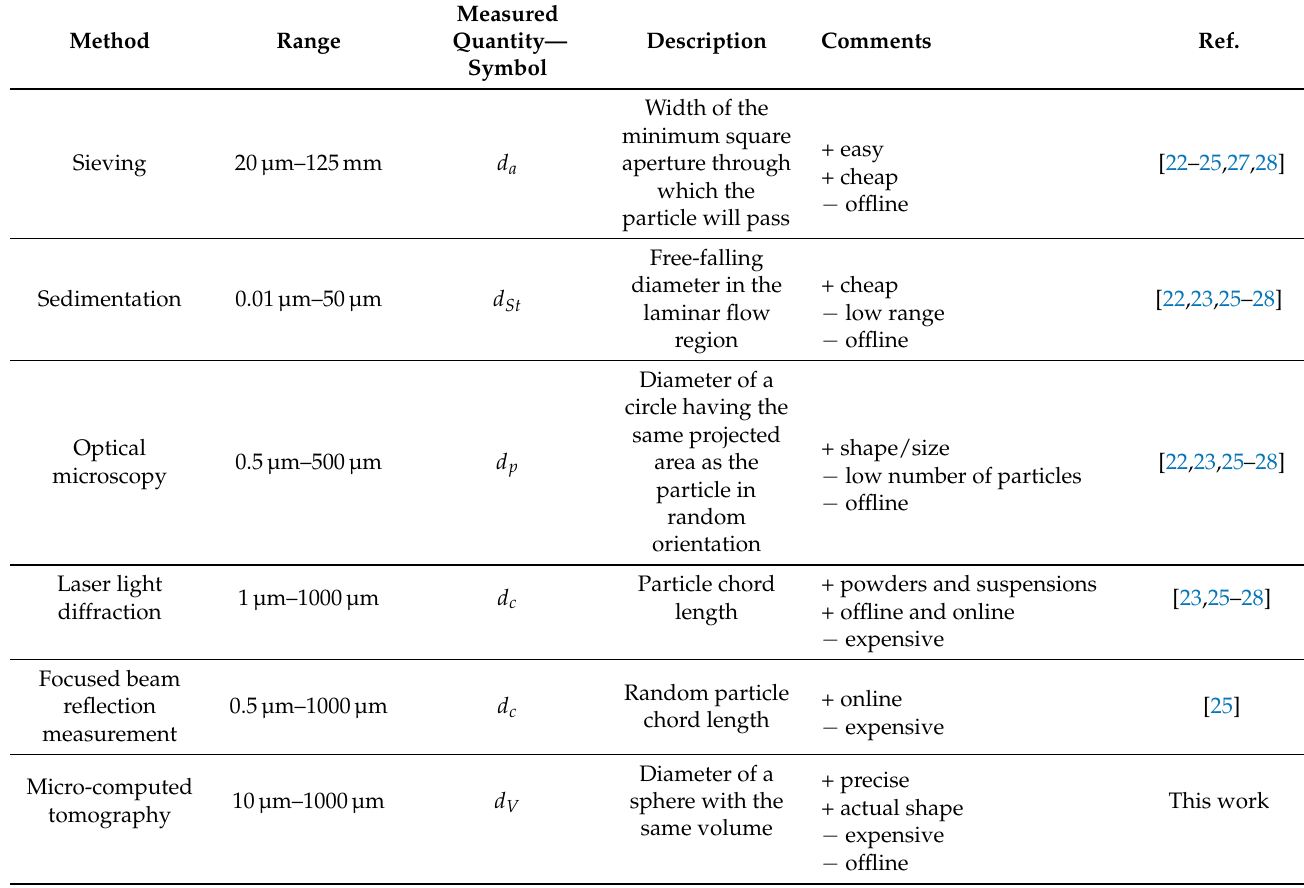
Table 1. Common techniques to measure the particle size distribution in crystalline products.